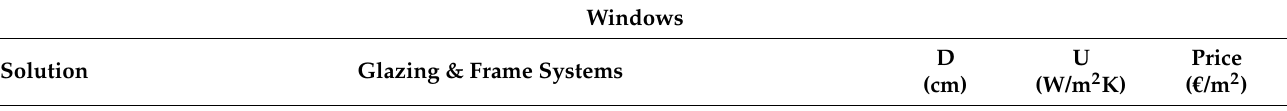
Table A3. Proposed renovation measures for openings: windows and external